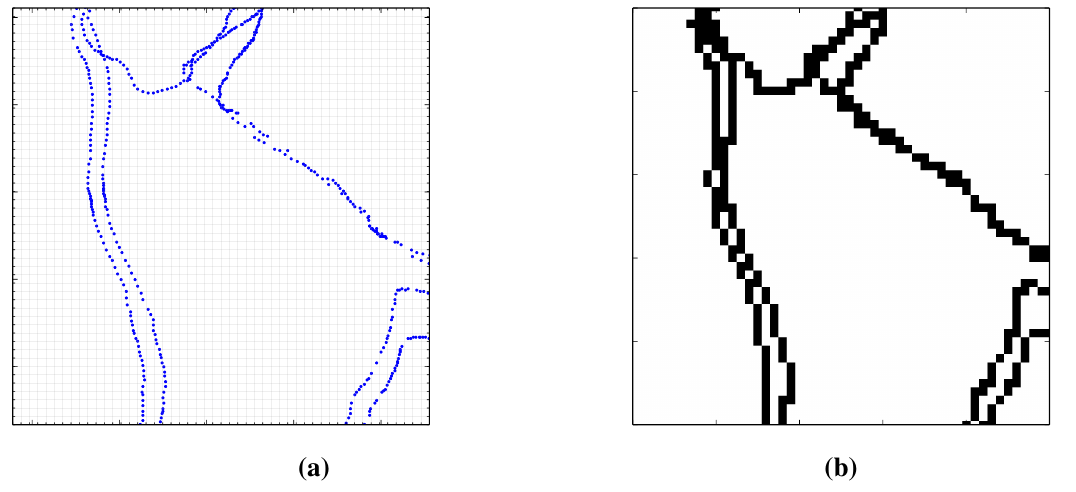
Figure 3. ( a ) Original track in blue are displayed together with the raster grid given by the Mercator projection at zoom level 14 with a tile size of 256 by 256 pixels. ( b ) The rasterized track that has been completed with Bresenham’s line drawing algorithm [26] to fill in any missing